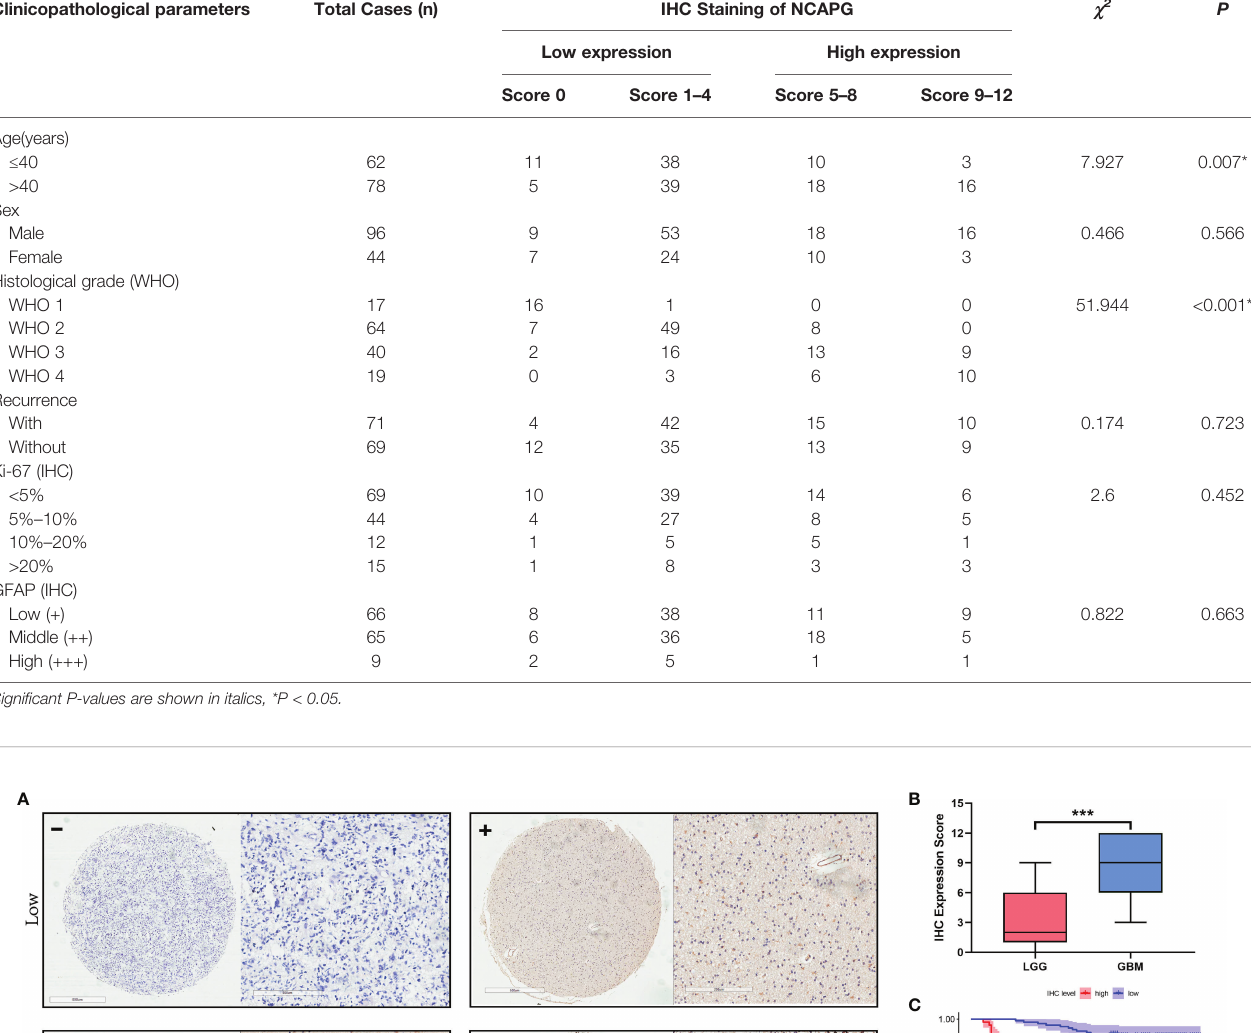
TABLE 1 | NCAPG expression and clinicopathological parameters in glioma tissue chips.